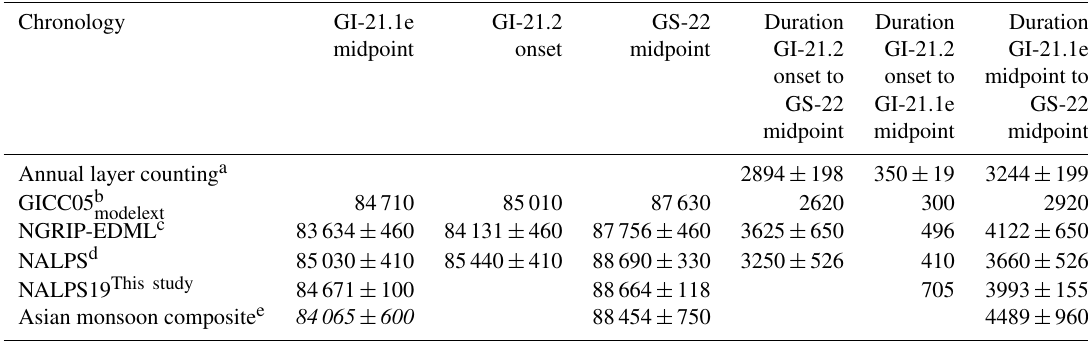
Table 4. The duration of GS-22 and the precursor event (GI-21.2) in various chronologies. All ages given relative to 1950 CE and with 2 σ